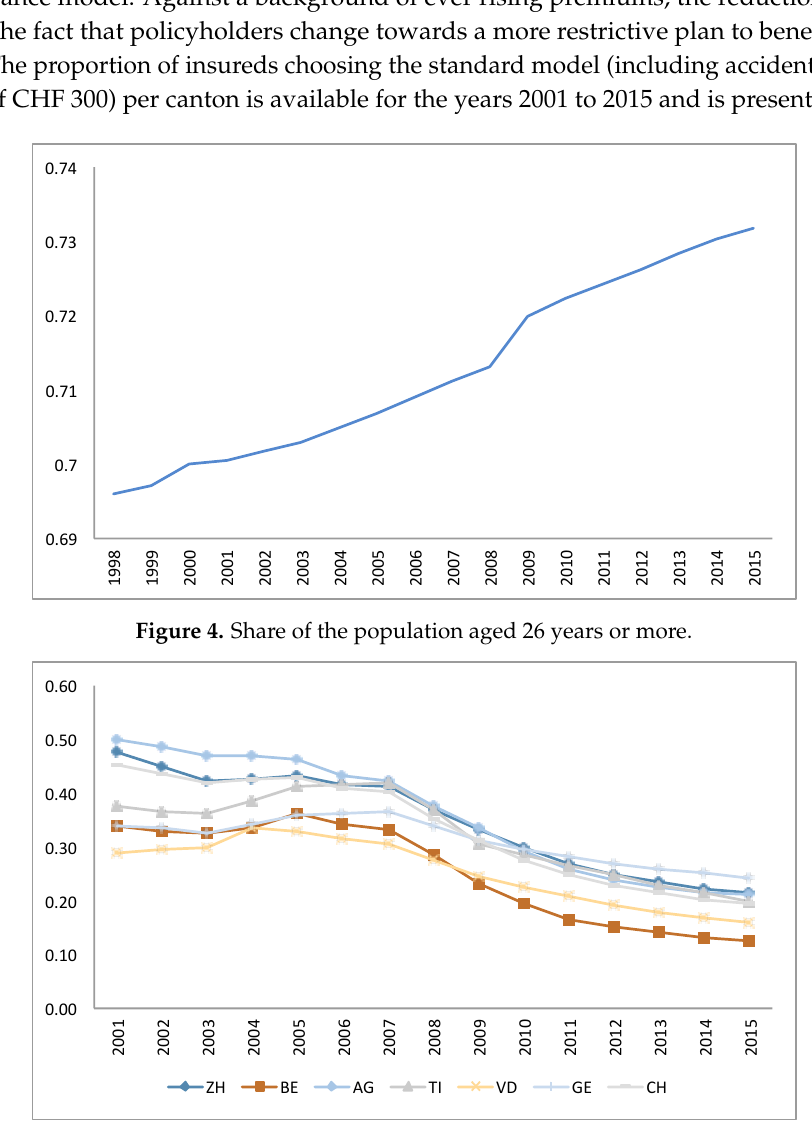
Figure 5. Share of insureds with the standard